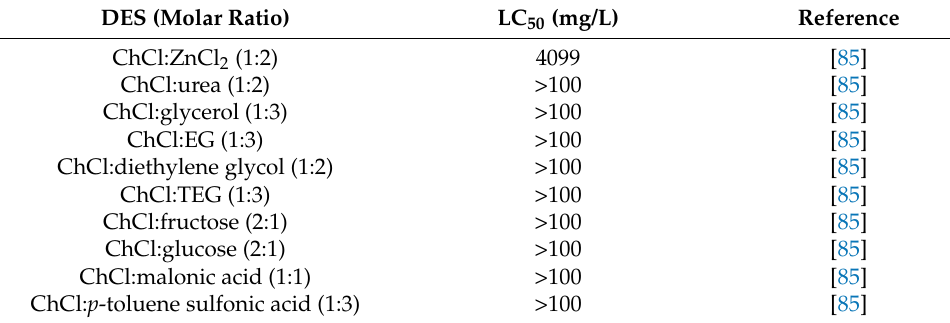
Table 6. Ecotoxicological data of some DESs in Cyprinus carpio